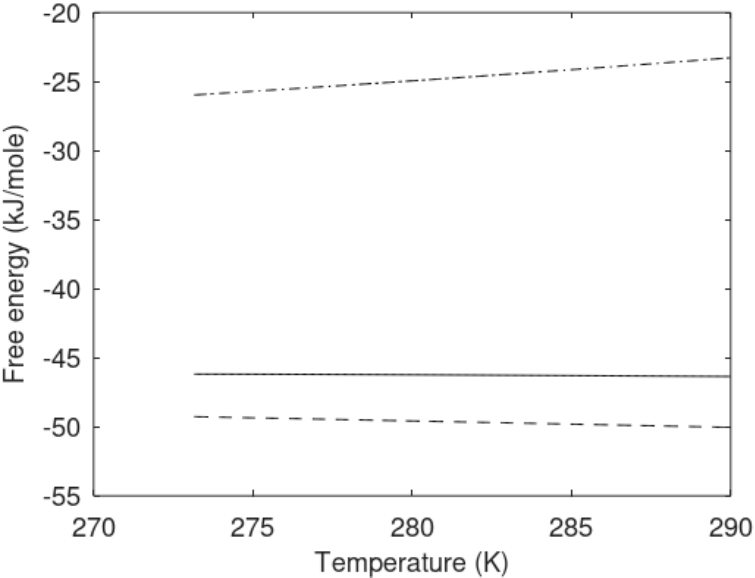
Figure 2. Hydrate free energy along the hydrate stability curve in Figure 1 (solid). Chemical potential for water in the hydrate (dashed) and chemical potential for CH4 (dash dot).